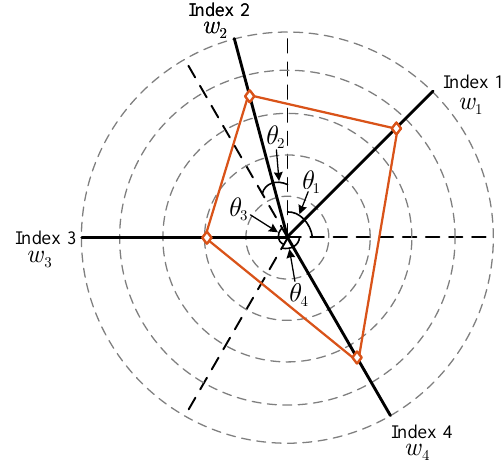
Figure 2. Radar chart analysis method with the performance metric